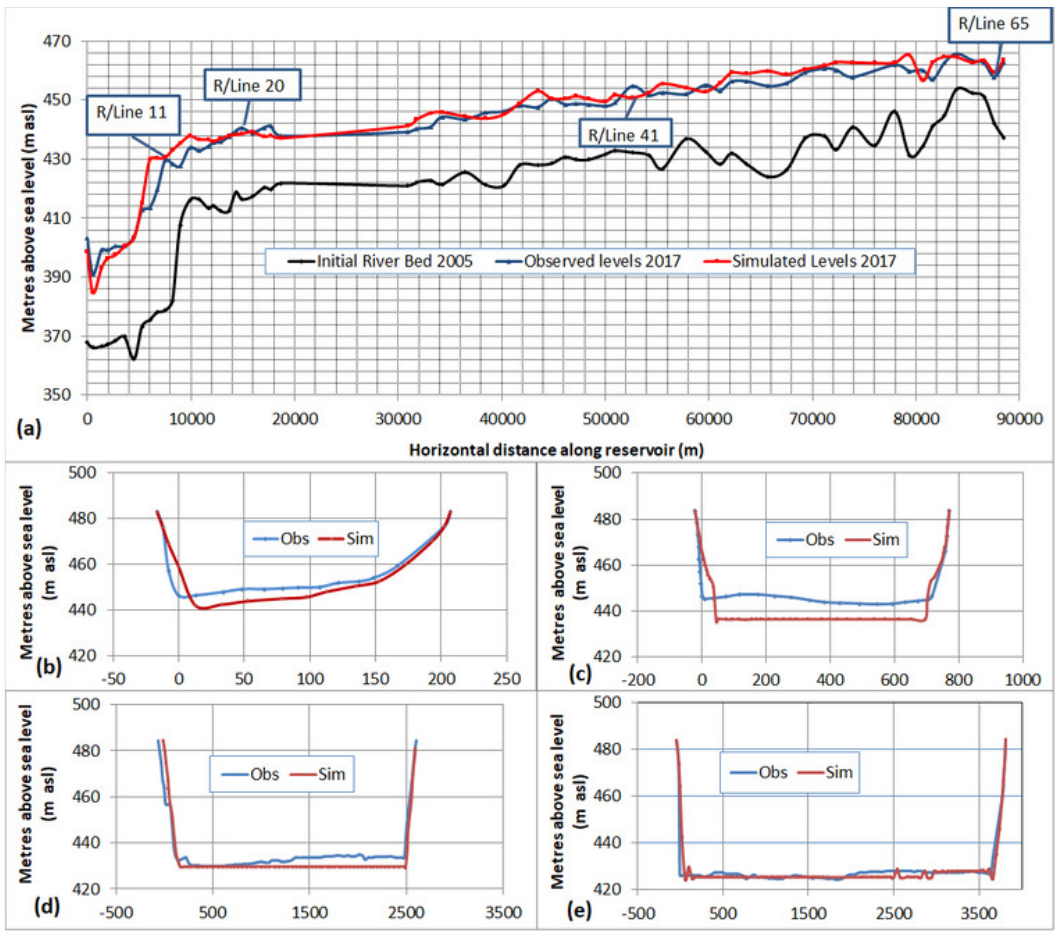
Figure 10. Comparison of observed and WA-ANN-simulated bed levels during validation for 2017: ( a ) along Tarbela Reservoir; ( b ) R/Line 65; ( c ) R/Line 41; ( d ) R/Line 20; ( e ) R/Line 11.